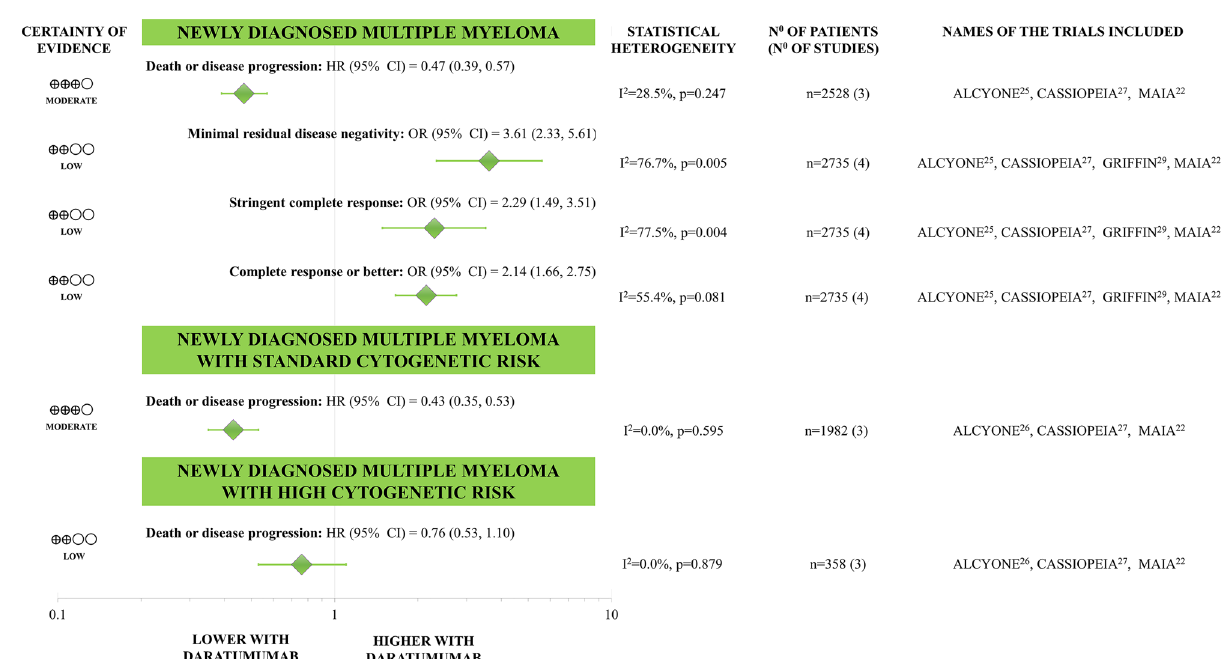
Figure 2. Clinical efficacy of backbone anti-myeloma regimens with and without daratumumab in newly diagnosed multiple